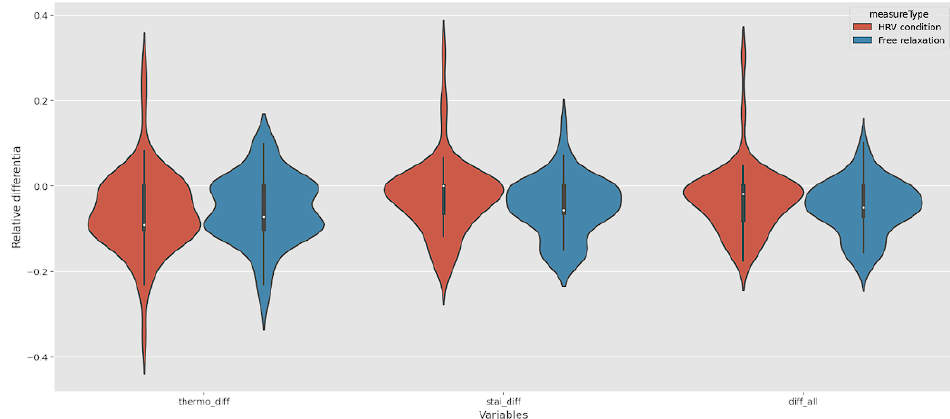
Figure 1. The violin plot of three variables creating during data processing and their relative differ- ences on different relaxation